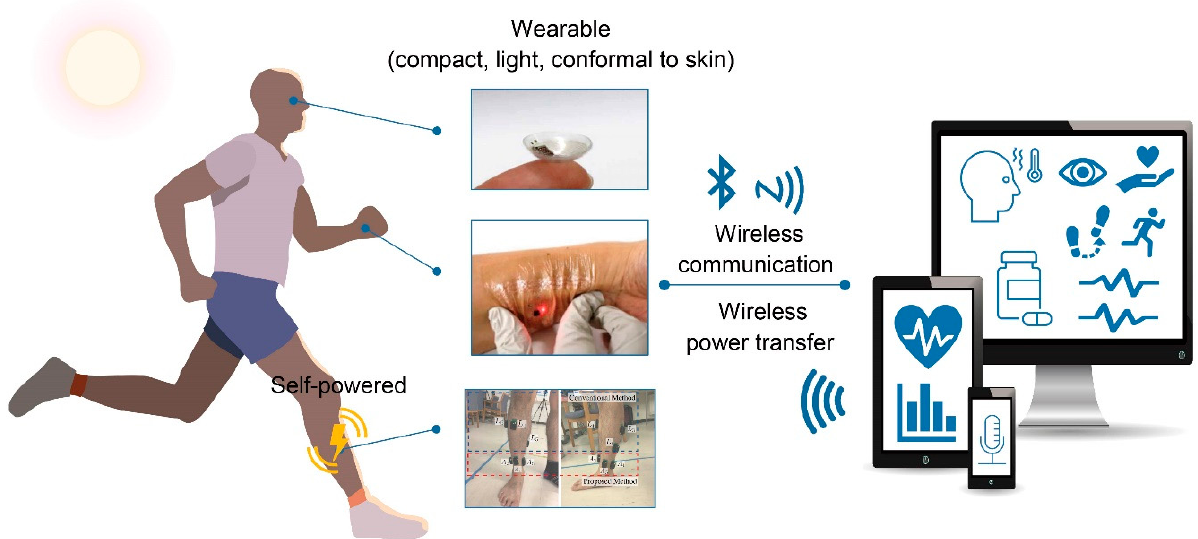
Figure 1. Schematics illustrating the recent progress in wearable devices for non-invasive diagnosis. ( top : reprinted with permission from [14]. Copyright 2020 American Association for the Advancement of Science; middle : reprinted with permission from [17]. Copyright 2019 John Wiley and Sons; bottom : reprinted with permission from [18]. Copyright 2019 MDPI)